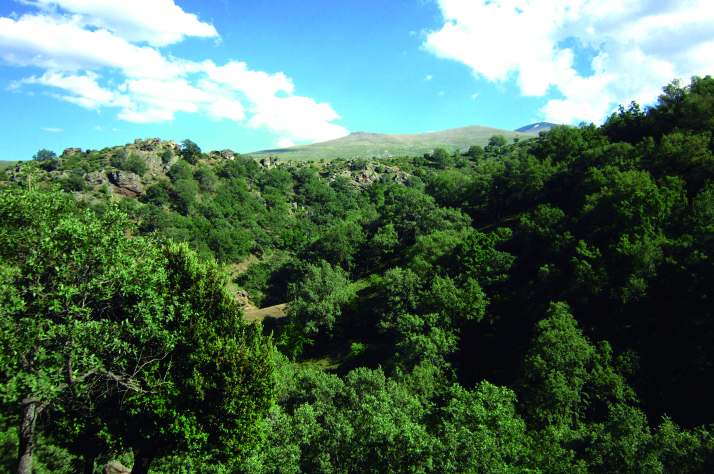
S2 plot Camarate, Q.
pyrenaica